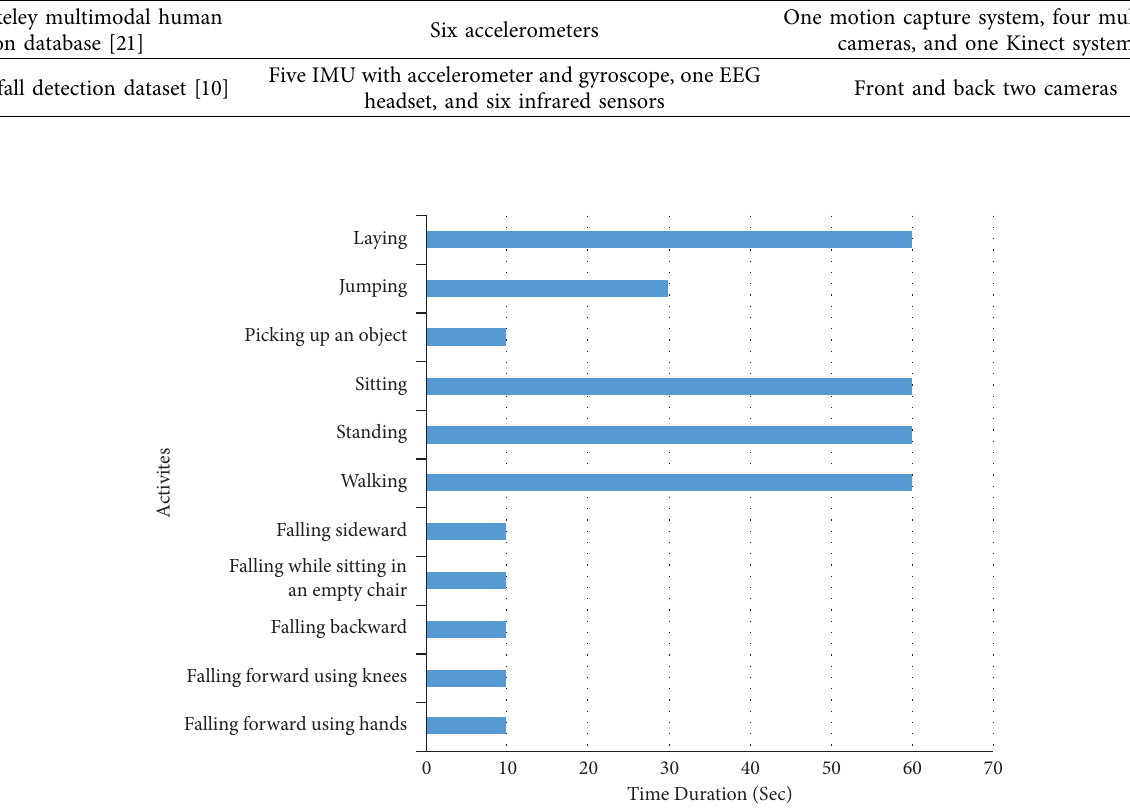
Figure 1: Activity data distribution.